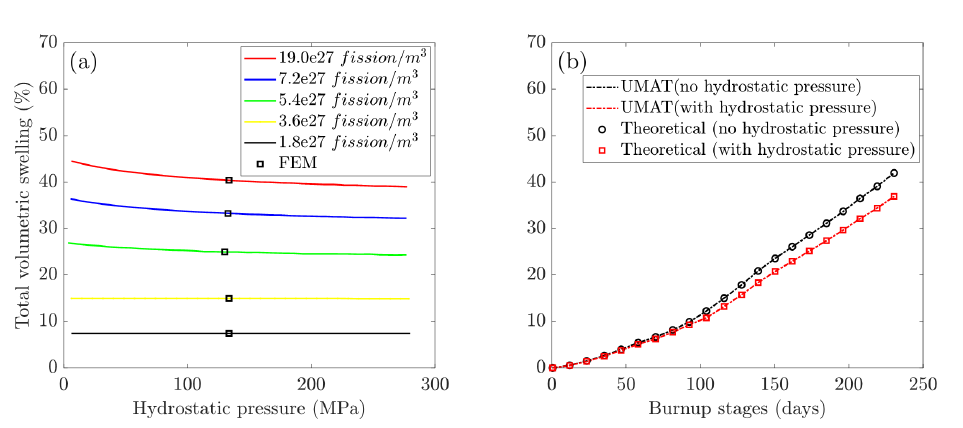
Figure 3. Model verification of cases with and without hydrostatic pressure: ( a ) plots of volumetric swelling vs. hydrostatic pressure with FEM results (hollow dots) compared to theoretical calculations (solid lines); ( b ) plots of volumetric swelling vs. burnup stages comparing UMAT results (dashed line) and theoretical calculations (hollow